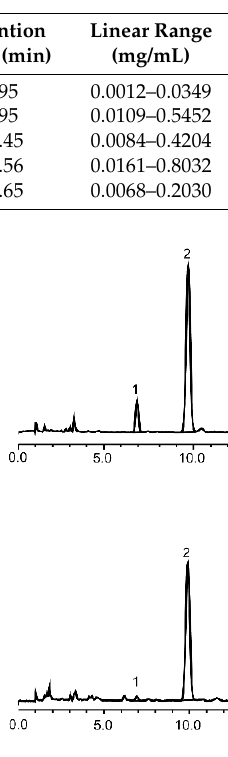
Figure 1. HPLC chromatograms of mixed standard solution (A) and sample solution (B) (1—linolenic acid, 2—linoleic acid, 3—palmitic acid, 4—oleic acid, and 5—stearic acid).